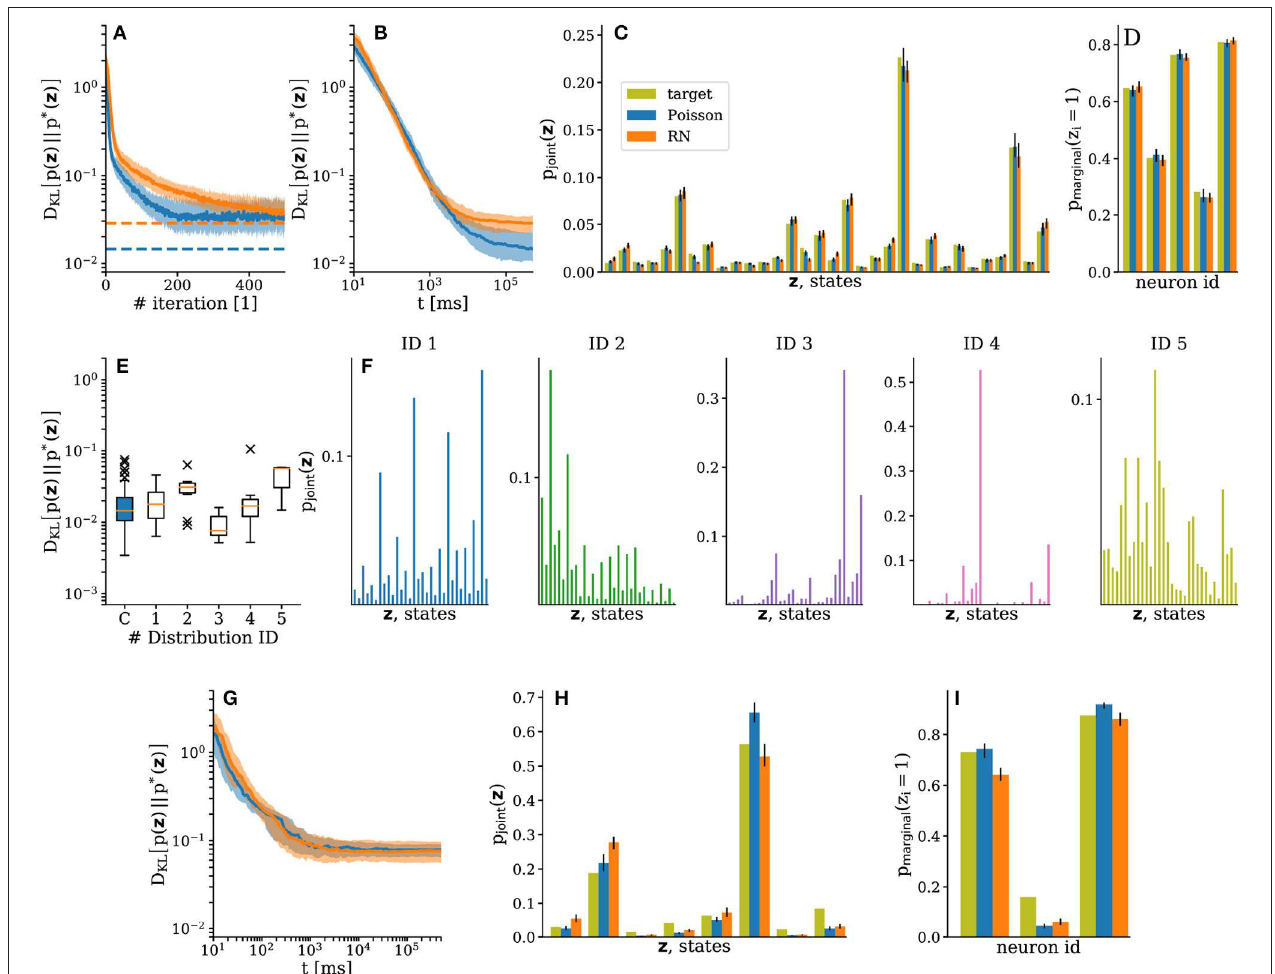
FIGURE 4 | Emulated SSNs sampling from target Boltzmann distributions. Sampled distributions are depicted in blue for setups with Poisson noise and in orange for setups using RNs. Target distributions shown in dark yellow. Data was gathered from 150 runs with random initializations. Median values are shown as dark colors and interquartile ranges as either light colors or error bars. (A) Improvement of sampled distributions during training. The observed variability after convergence (during the plateau) is not due to noise in the system, but rather a consequence of the weight discretization: when the ideal (target) weights lie approximately mid-way between two consecutive integer values on the hardware, training leads to oscillations between these values. The parameter configuration showing the best performance during a training run—which, due to the abovementioned oscillations, was not necessarily the one in the final iteration—was chosen as the end result of the training phase. Averages of these results are shown as dashed lines. (B) Convergence of sampled distributions for the trained SSNs. (C,D) Sampled joint and marginal distributions of the trained SSNs after 5 × 10 5 ms , respectively. (E) Consistency of training results for different target distributions using Poisson noise. Here, we show a representative selection of 6 distributions with 10 independent runs per distribution. The box highlighted in blue corresponds to the target distribution used in the other panels of Figure 4 . The data is plotted following the traditional box-and-whiskers scheme: the orange line represents the median, the box represents the interquartile range, the whiskers represent the full data range and the × represent the far outliers. (F) Target distributions corresponding to the last five box-and-whiskers plots in (E) . (G) Convergence of conditional distributions for the trained SSNs. (H) and (I) Sampled conditional joint and marginal distributions of the trained SSNs after 5 × 10 5 ms ,